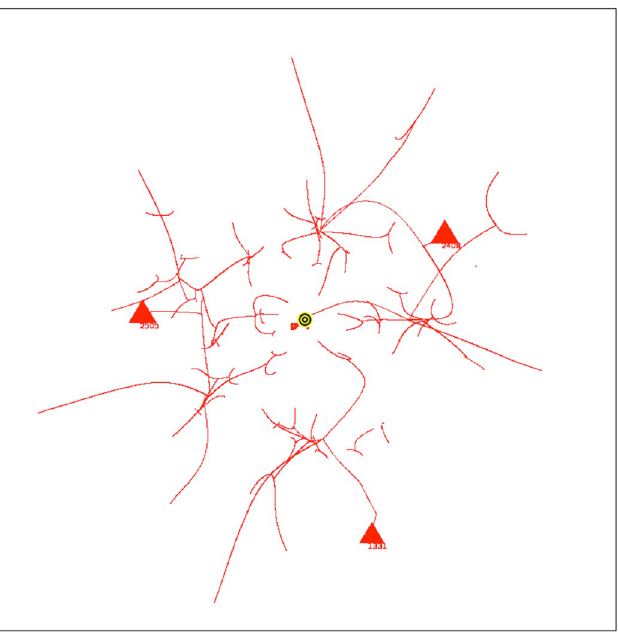
Fig 7. Overlay of simulations in red, blue, green, and brown, with four different values of g, all have AIB = 100, seed = 71 and 2580 iterations. The final red tracks cover the blue, green and brown tracks perfectly: 1) red g = 2.0 × 10 − 5 , ET = 57346; 2) blue g = 7.0 × 10 − 5 (default), ET = 30653; 3) green g = 3.0 × 10 − 4 , ET = 14806; 4) brown g = 1.0, ET = 256.46.